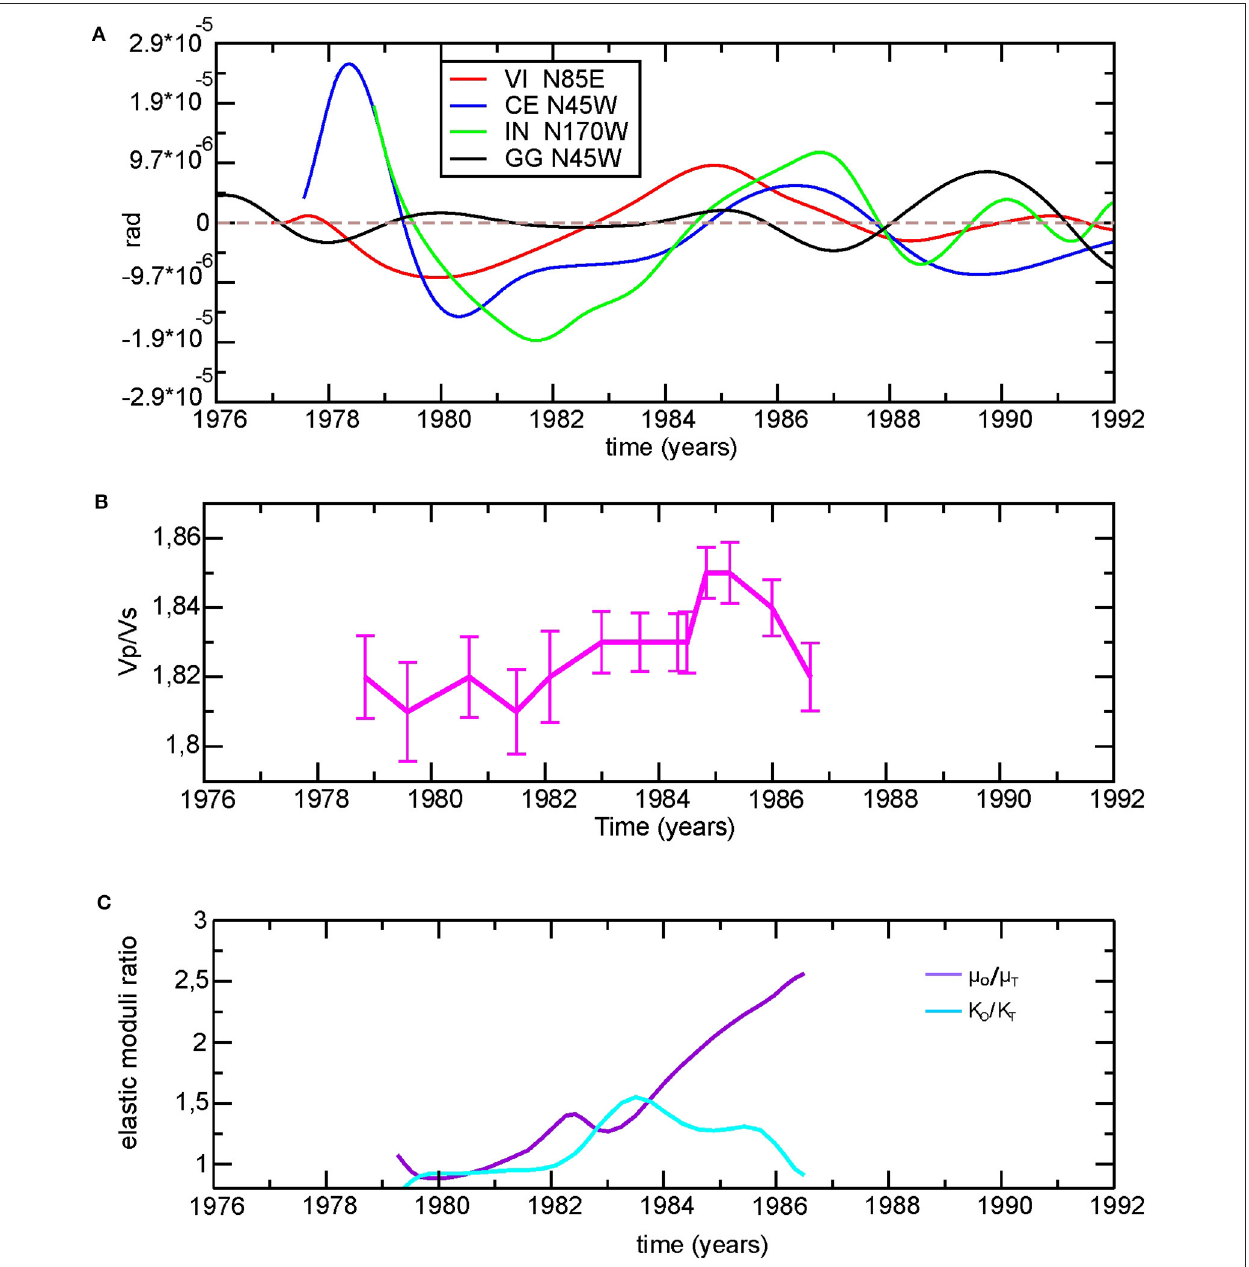
FIGURE 12 | (A) The same curves as Figure 6 (positive, in the direction indicated in the legend). A gain of 10 4 is applied to the GG signal to allow comparison with the other stations. (B) V p /V s from Table 3 of Mao et al. (1989), with the error bars; (C) the ratio between the observed rigidity ( µ O ) and bulk modulus (K O ) and the theoretical rigidity ( µ T ) and bulk modulus (K T ), from Mao et al. (1989)